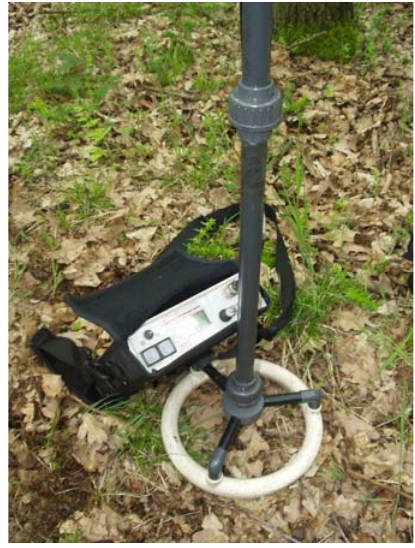
Fig 3. Vertical magnetic workability sensor The oil-derivative substances generated by traffic migrated chiefly in a vertical direction, and after reaching the underground water level they moved horizontally in the area of the capillary rise. The substances inhibited the development of soil microorganisms harming both tro- phic and aerobic conditions, and to a smaller degree due to toxic